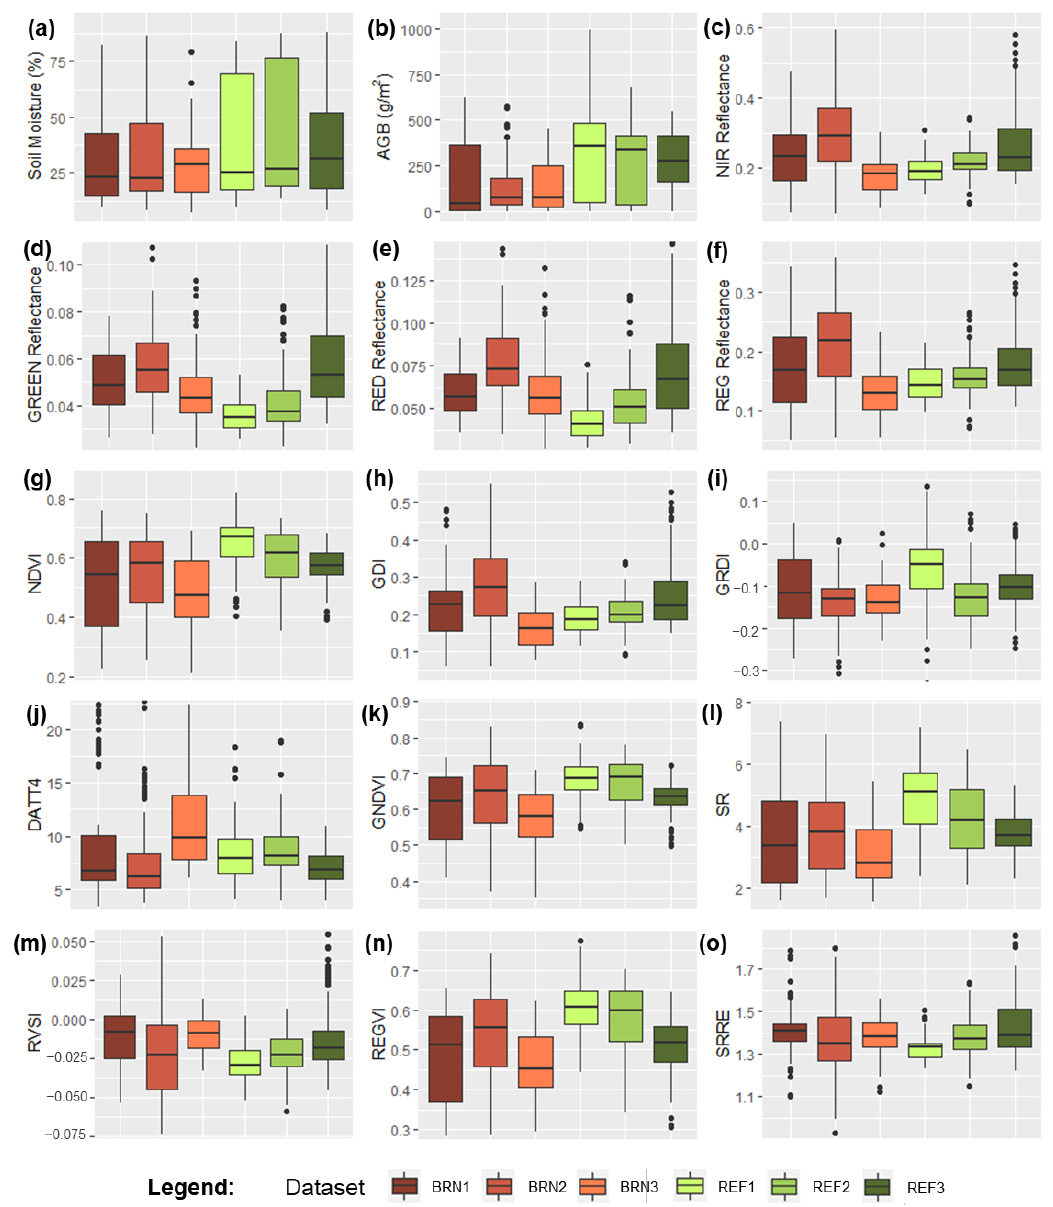
Figure 3. Box plots of the sampled metrics at the BRN (i.e., fire damaged) and REF (i.e., undamaged) sites and different field measurement campaigns; dataset BRN1 contains samples collected on site